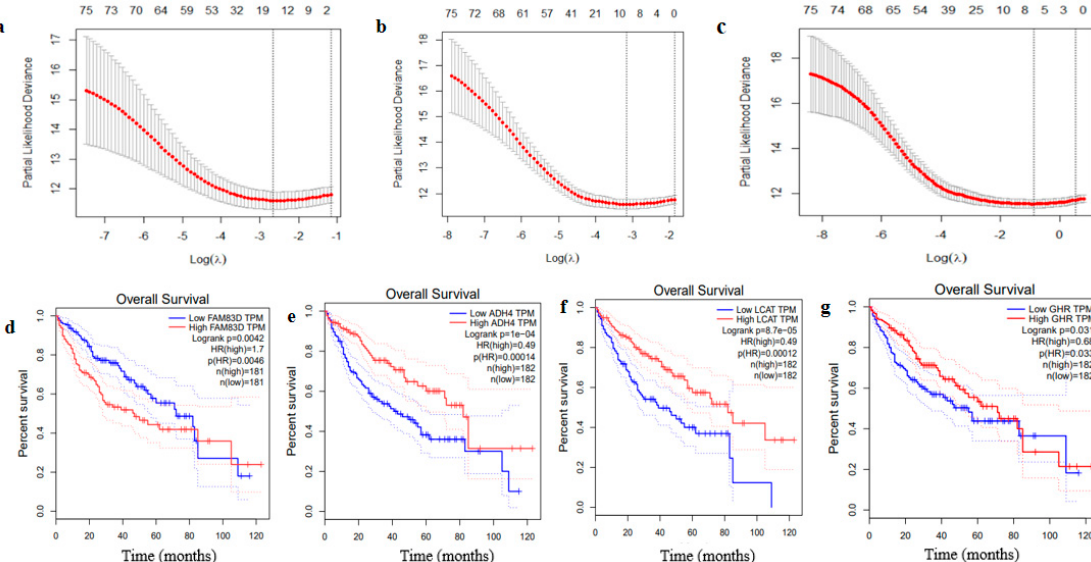
Figure 3. Identifying relevant prognostic genes from hepatocellular carcinoma (HCC) patients based on TCGA dataset. Tenfold cross validation (10-CV) gained prognostic genes by minimum lambda values for elastic net ( a ), lasso ( b ), adaptive lasso ( c ). X-axis shows that regularization process and y-axis show partial likelihood deviance. The minimum value numbers of prognostic genes by three algorithms are shown with two vertical lines that show one standard deviation from the minimum values. Kaplan–Meier (KM) survival analysis of high expression and low expression identified by BSR model ( d – g ). BSR, Best subset regression.